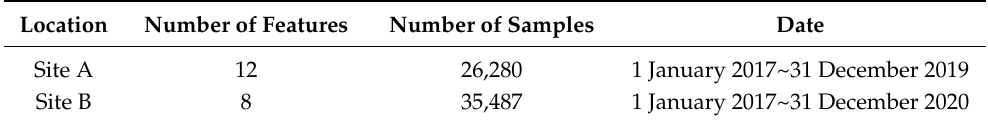
Table 1. Details of the datasets.